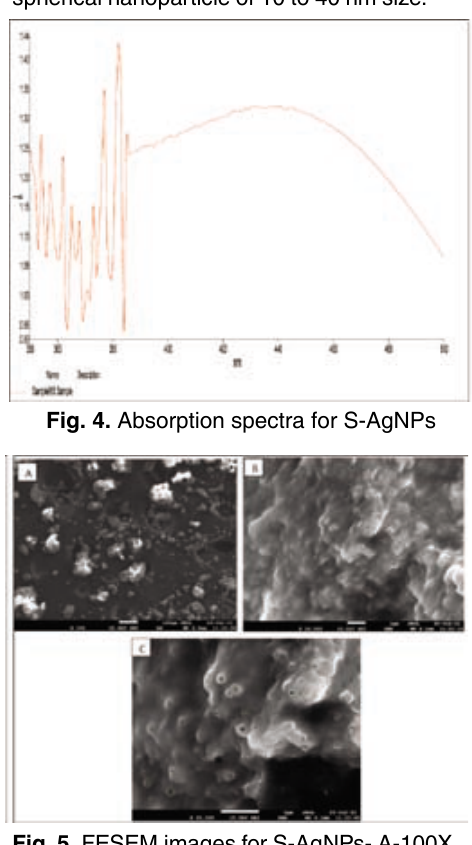
Fig. 5. FESEM images for S-AgNPs- A-100X, B- 10,000 X and C- 20,000 X magnification